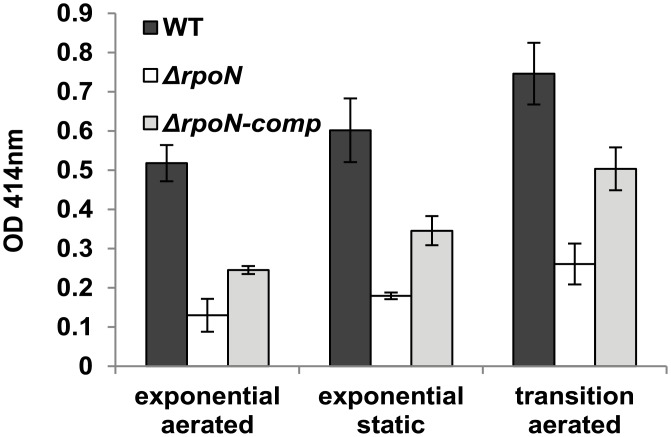
Toxin production.Production of non-hemolytic toxin (NheA) measured in BHI at 30°C with aeration at mid-exponential (OD 600 nm = 0.2) and end-exponential (OD 600 nm = 1) growth phases, and at mid-exponential (OD 600 nm = 0.2) phase during static growth.